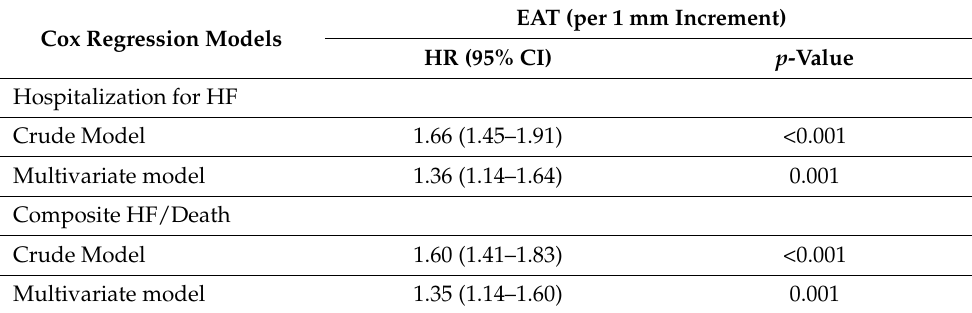
Figure 1. Associations of EAT burden with myocardial mechanics based on speckle-tracking. Model was adjusted for age, sex, BMI, hypertension, diabetes, lipid profile of cholesterol and HDL-C, prior CVD, HFpEF, eGFR, and LV mass. CVD, cardiovascular disease; eGFR, estimated glomerular filtration rate; HDL-C, high density lipoprotein cholesterol; HFpEF, heart failure with preserved ejection fraction; LV, left ventricle; MetS, metabolic syndrome. All strain and strain rate values are reported as absolute values |x| and further standardized. Table 3. Multivariate cox regression models in predicting hospitalization for HF